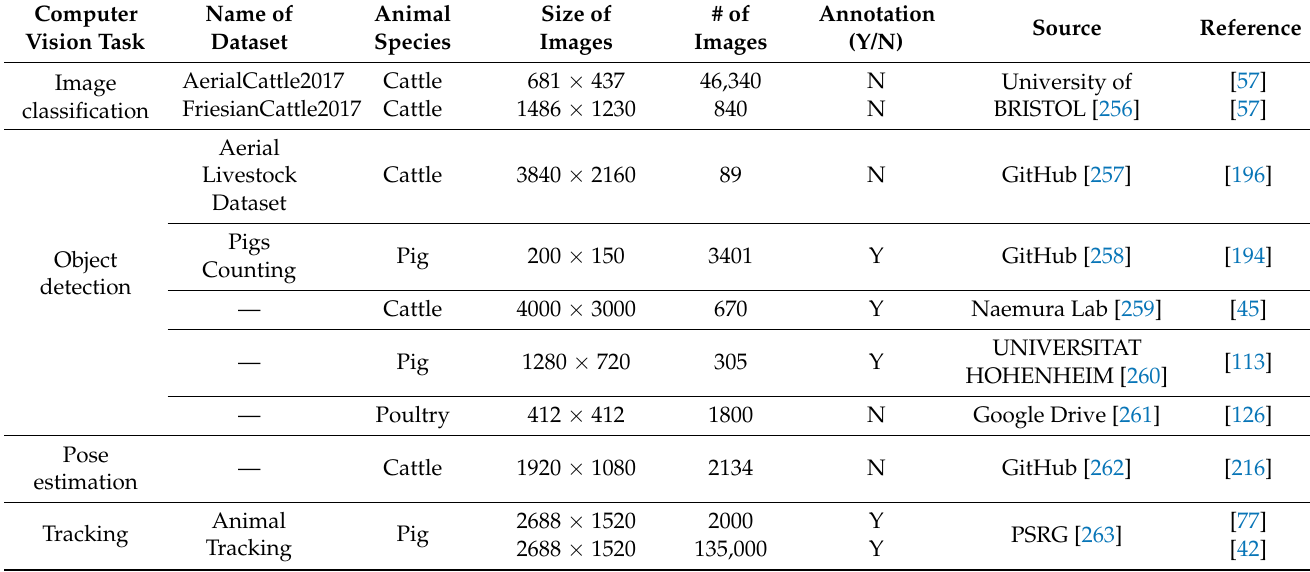
Table 10. Available datasets of animal